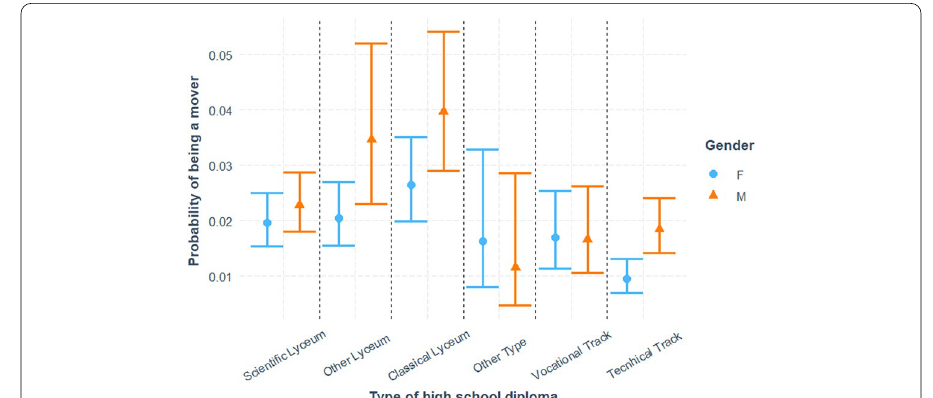
Fig. 7 Model 2: estimated marginal probabilities of the interaction between high school diploma type and gender